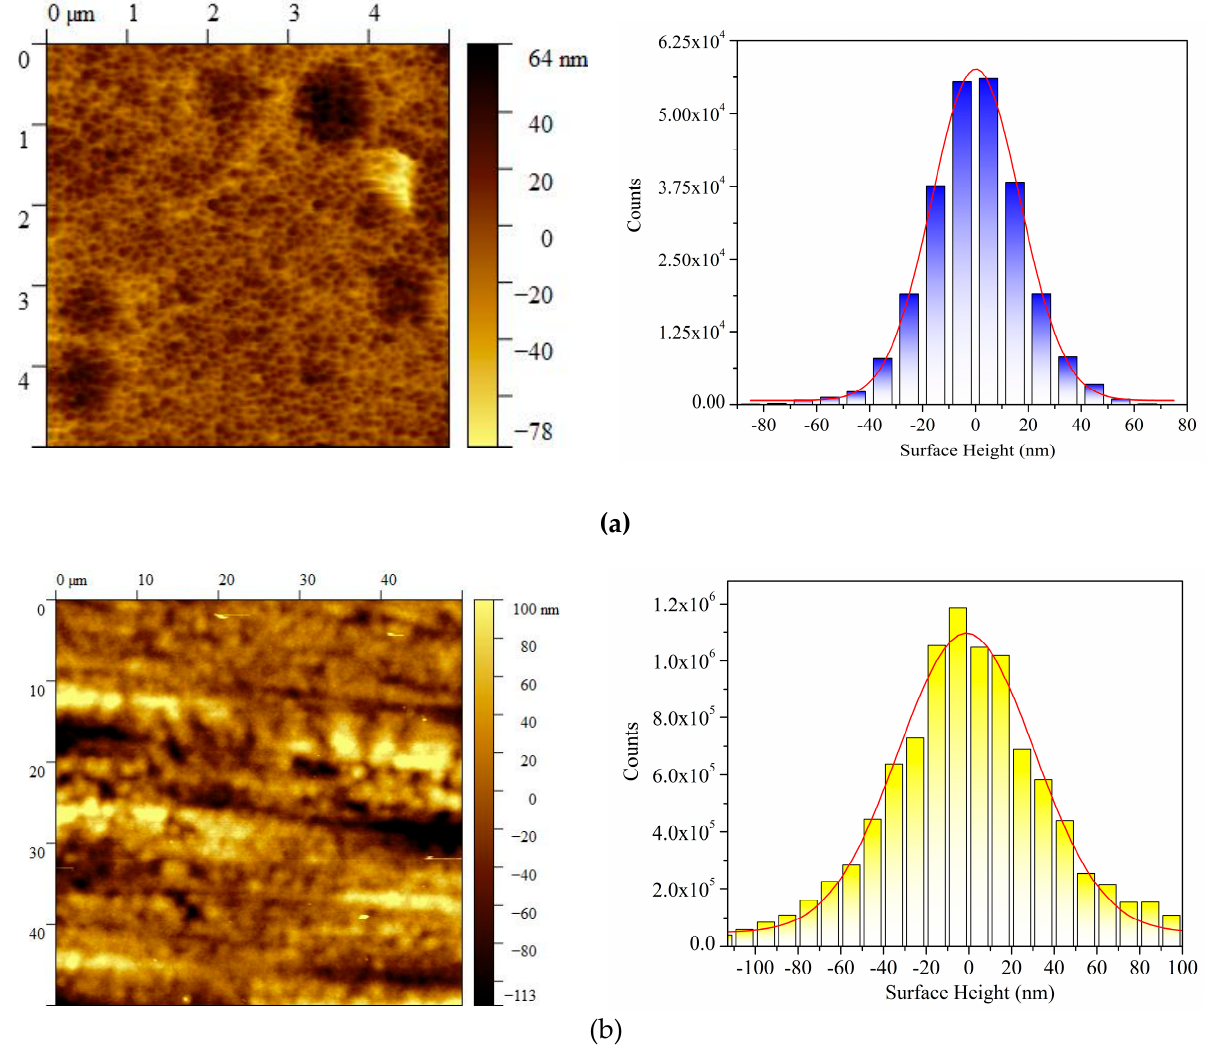
Figure 3. AFM images for the surface topography and surface roughness distribution ( a ) the semiconductor die metallic pad and ( b ) the package substrate metallic pad.